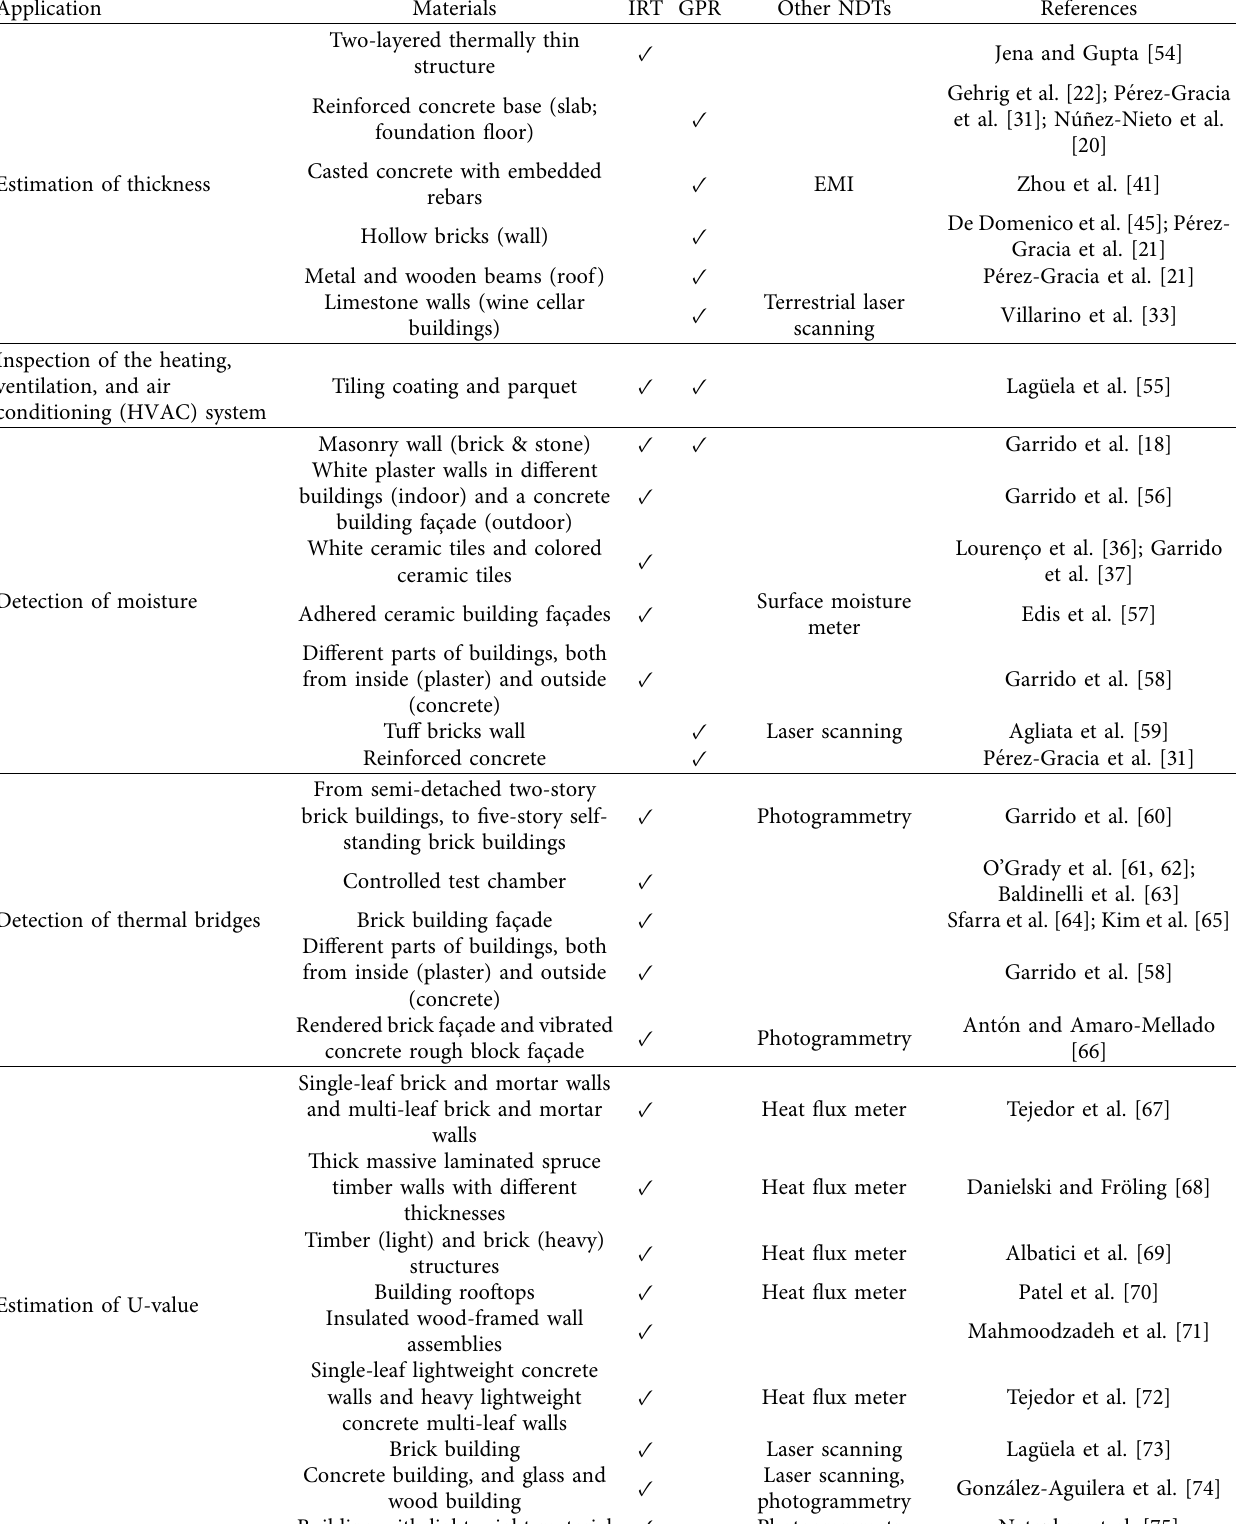
Table 3: Summary table of the state-of-the-art of IRT and GPR techniques applied to energy and well-being conservation in the building